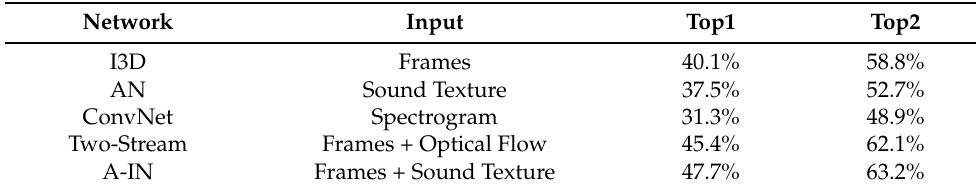
Table 2. Structure of the